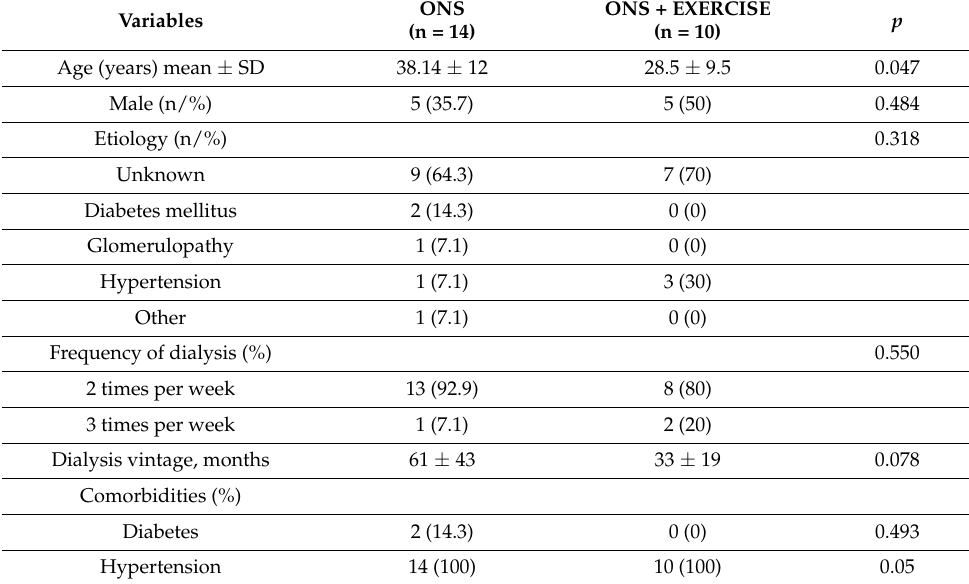
Table 1. Demographics and baseline characteristics.